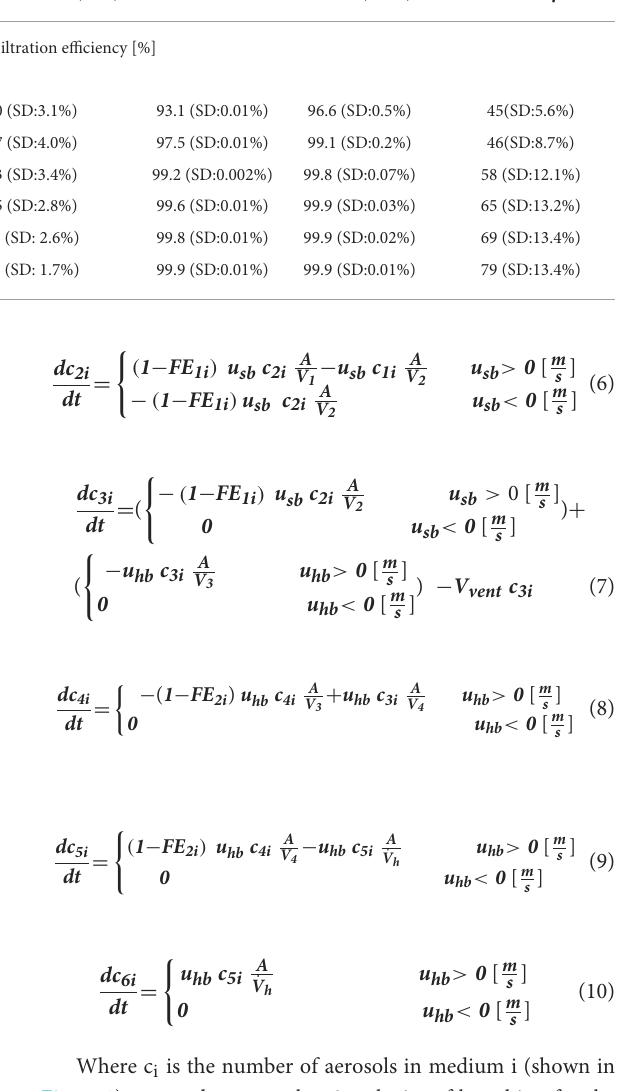
A variety of respiratory viruses like influenza virus and acute respiratory syndrome (SARS) coronavirus are available in high concentrations in infected human saliva and respiratory mucus. The produced aerosols from human saliva will carry these viruses by breathing, talking, and coughing. The virus content of these aerosols is dependent on the aerosol’s